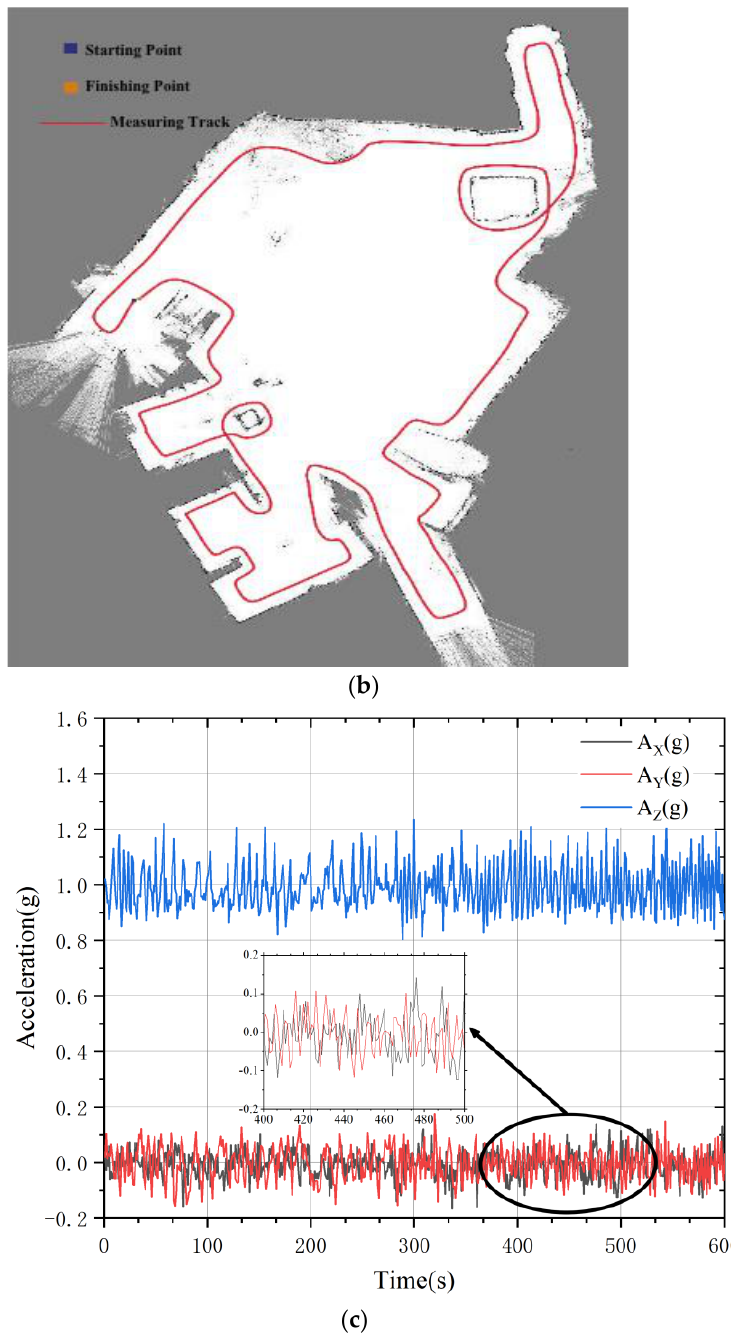
Figure 8. Experiment I navigation test: ( a ) Outdoor navigation route, red represents indoor track, yellow represents outdoor track; ( b ) Indoor synchronize mapping; ( c ) System acceleration after fusion.